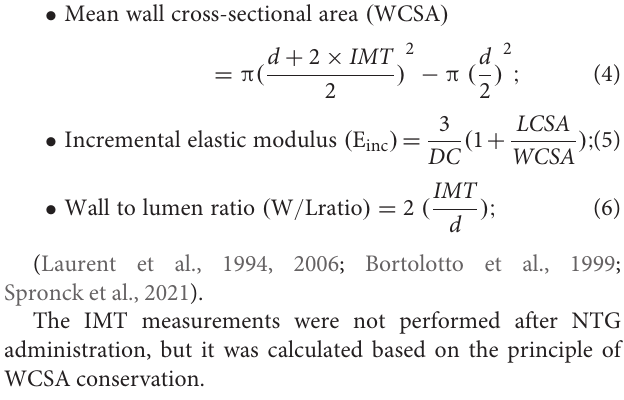
1 shows the baseline demographic, clinical, pharmacological, and biological characteristics of